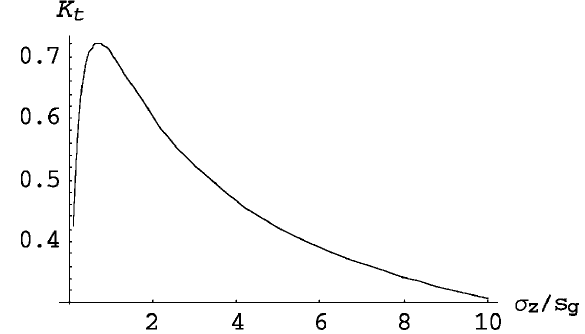
(cid:1) (cid:3) (cid:3) which determines the trans- =s t s g